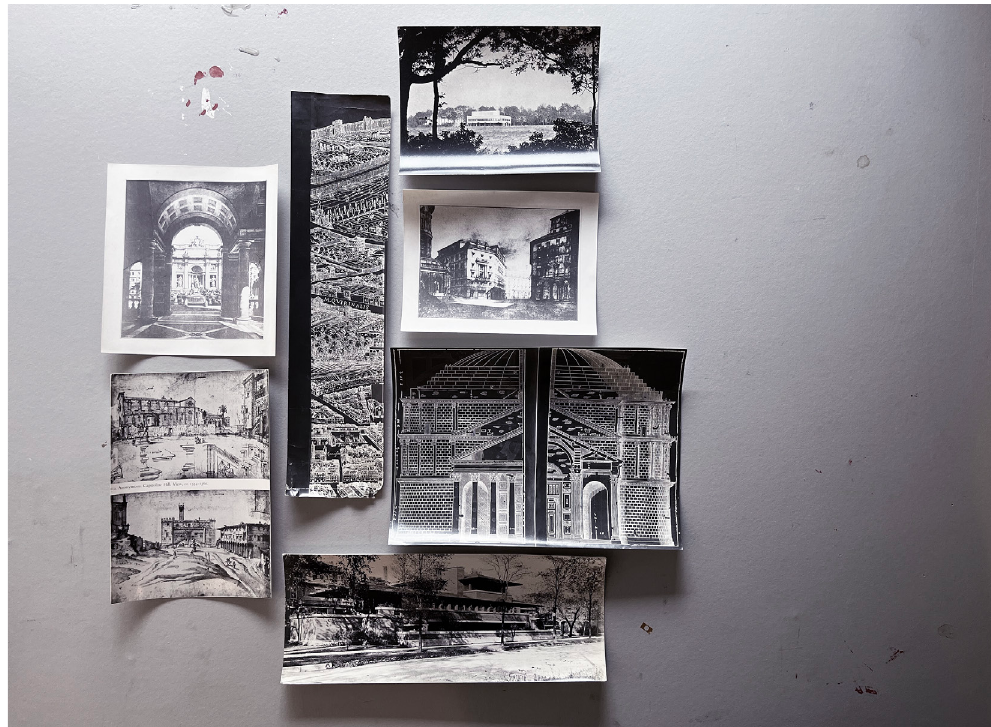
Fig. 1 Robert Venturi, Scott Brown Collection (225.XI.108),